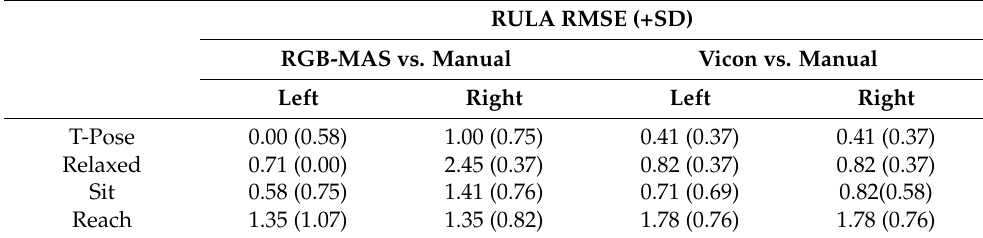
Table 6. RMSE (+SD) values obtained when respectively comparing RGB-MAS and the Vicon RULA with the manual